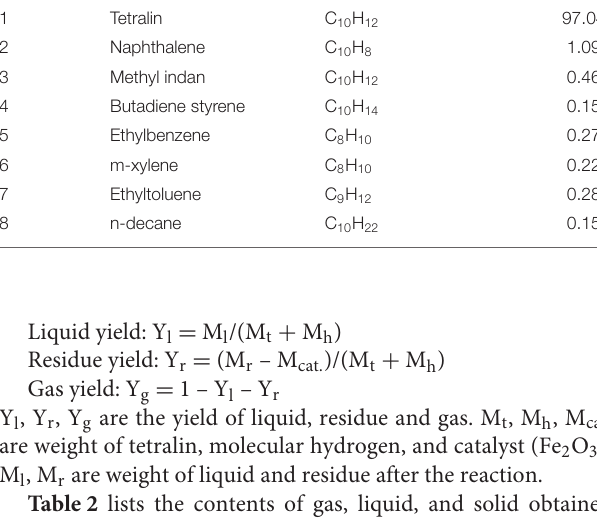
TABLE 3 | Composition of the raw material tetralin. NO.